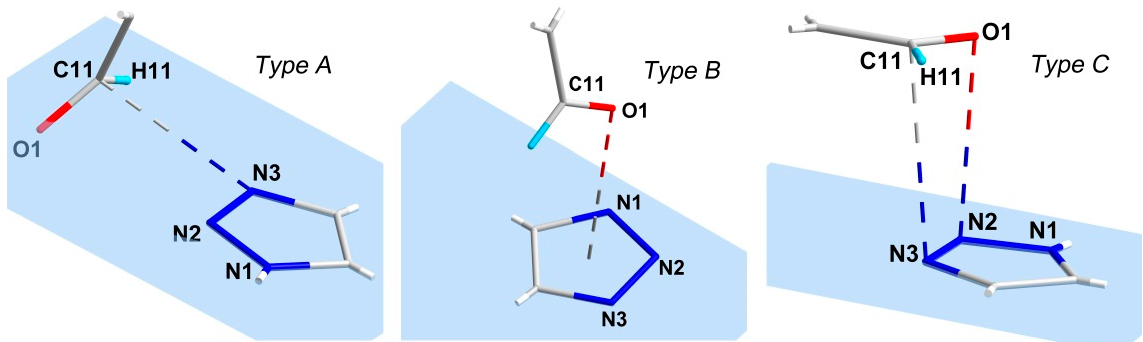
Figure 3. Three types ( n → π * ( Type A , C11–N3 viii 3.020(4) Å; symmetry code: (viii) x , − y + 1, z − 0.5),